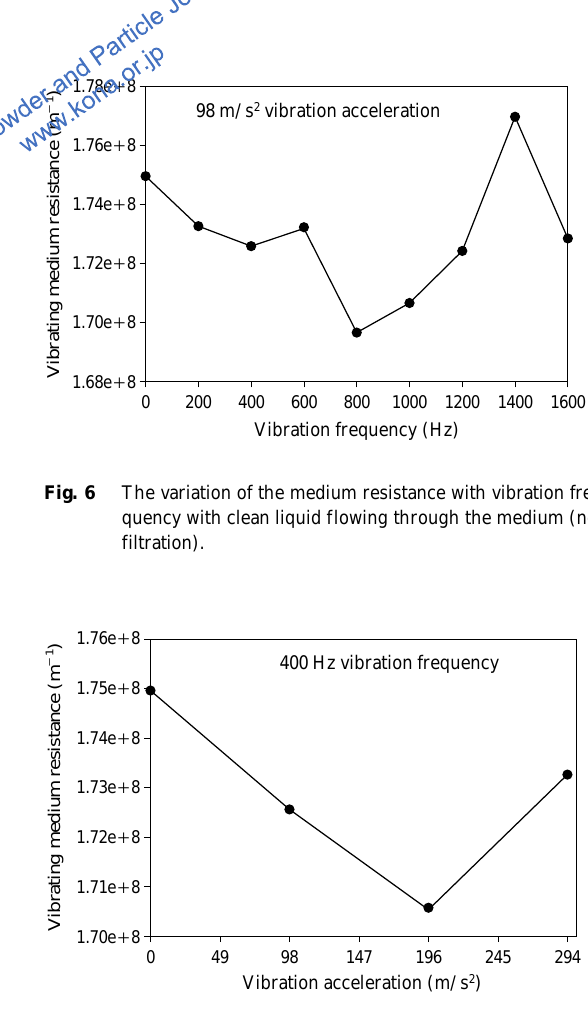
depends on the vibration characteristics. Different vibration accelerations lead to different cake forma- tion processes. The qualitative state of the cake or suspension in the filter chamber was observed visu- ally through the perspex walls of the filter. When the vibration acceleration was low at a particular fre- quency, for example 49 m s (cid:2) 2 at 200 Hz, the cake for- mation process was similar to that without vibration; the particles progressed in a uniform direction through the filter vessel in an orderly manner to form the cake, as shown in Figure 8(b) . The cake forma- tion process changed with an increase of the vibration acceleration. At the beginning of filtration, the state of the particles was as shown in Figure 8(a) , that is, the particles were uniformly distributed above the filter medium. Once the filtration had started, cake formed on the filter medium but the morphology of the cake was dependent on the vibration acceleration. For